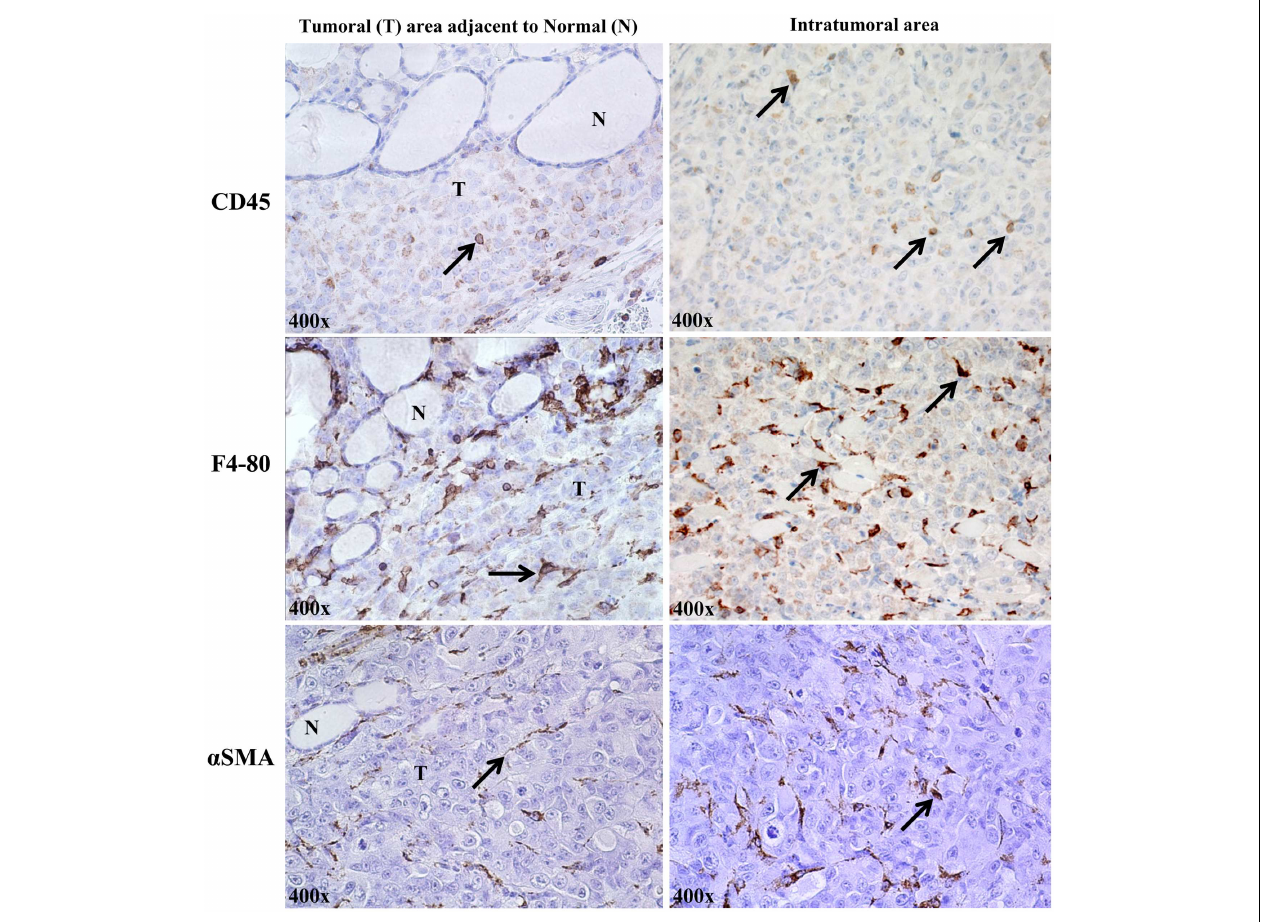
membrane); ∼ 8% were identified as macrophages [F4/80 (pan macrophage marker), localized to plasma membrane]; and ∼ 5% were spindle-shaped pericytes, identified by staining for cytosolic α SMA (alpha-smooth muscle